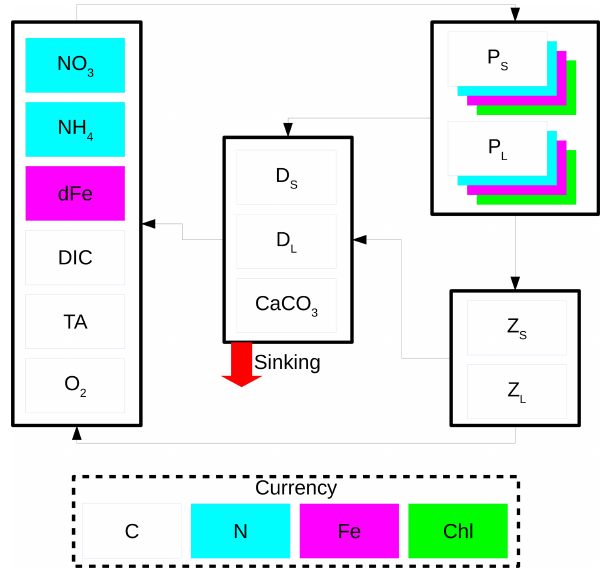
Figure 1. Schematic of the CanOE biology model. Model curren- cies including chlorophyll (Chl) are indicated by coloured boxes except oxygen (O 2 ) and carbonate (CaCO 3 ). Arrows indicate flows of carbon (C), nitrogen (N), and iron (Fe) between compartments containing small (S) and large (L) phytoplankton (P), zooplankton (Z), and detritus (D) components; counterflows of oxygen are not